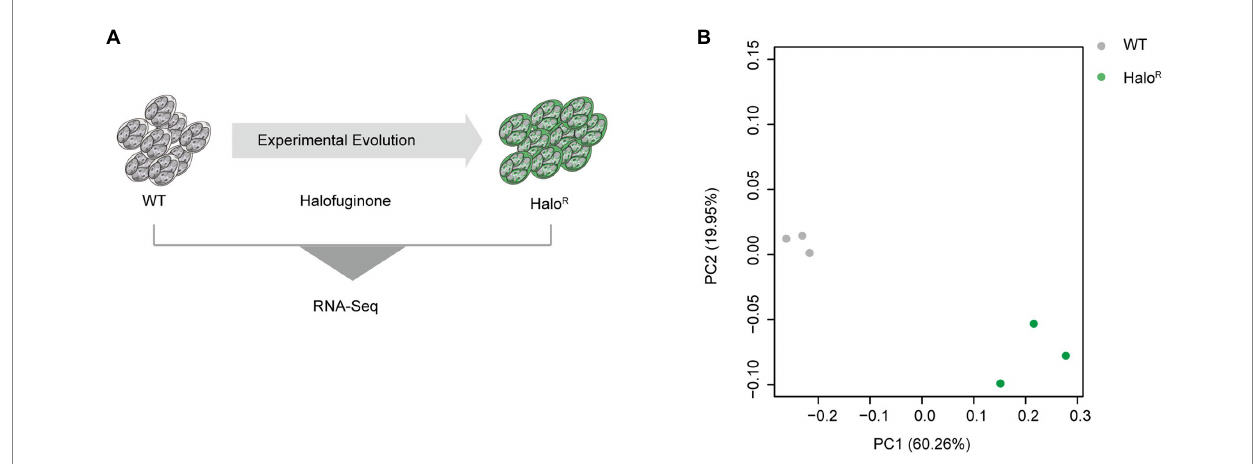
FIGURE 4 Overview of transcriptome analysis between halofuginone-sensitive strain and resistant E. tenella strains. (A) Schematic illustration of the induction of halofuginone-resistant strain. (B) PCA plots for transcriptome samples labeled by different strains. Gray dots represent wild-type strains while green dots represent halofuginone-resistant